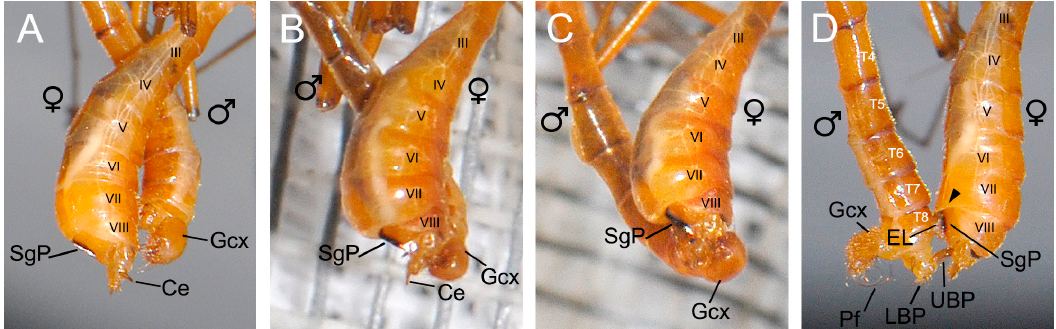
Figure 4. The dorsal end (female segments III ‐ VIII) of copulating Terrobittacus implicatus , showing the swelling process of the female abdomen. ( A ) The male makes a short pause at the tip of the female tergum, getting a positioning. ( B ) The female abdomen begins to swell from segments III to VII. ( C ) The epandrial lobes of the male move along the route formed by the abdominal segments VII and